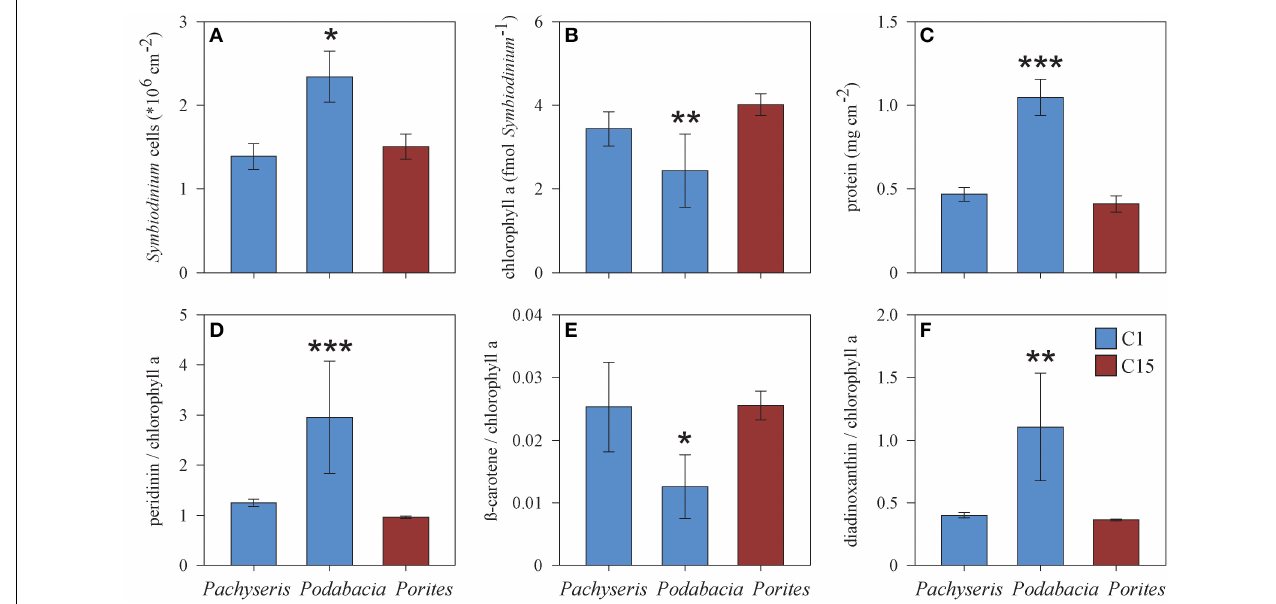
FIGURE 5 | Comparison of physiological parameters (A–F) between the corals Podabacia and Pachyseris (both hosting Symbiodinium type C1) and Porites (hosting Symbiodinium C15) for samples from